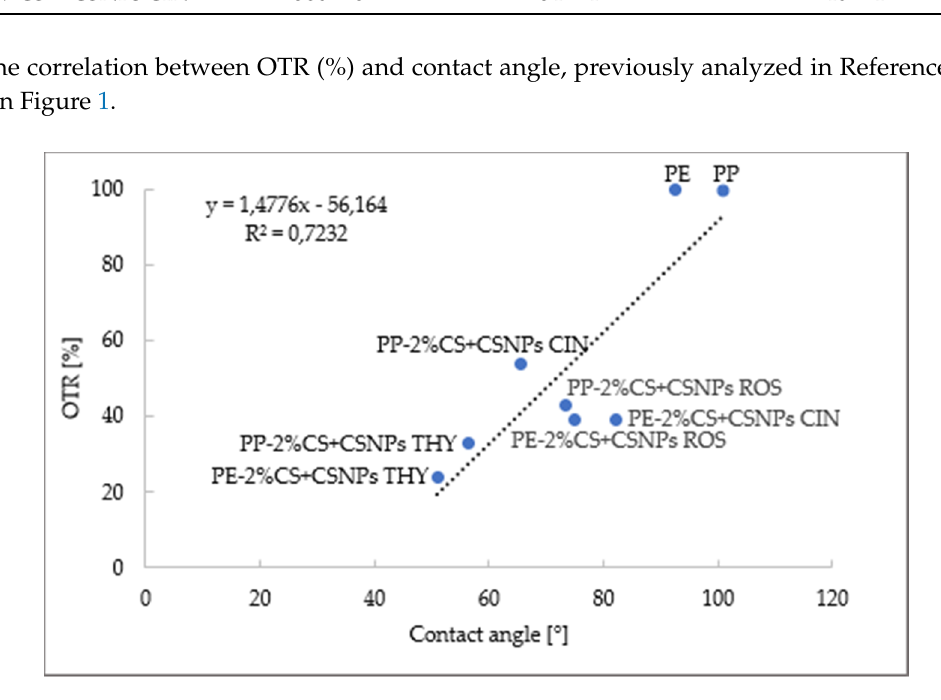
Figure 1. The correlation between contact angle and OTR.